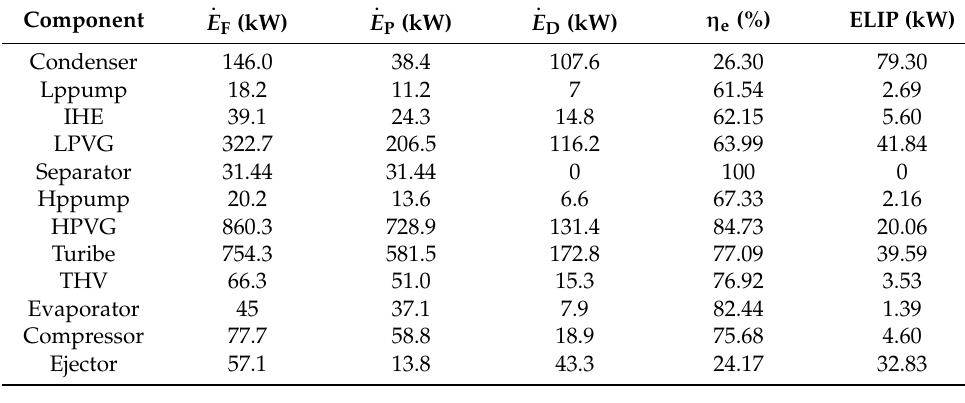
Table 11. Exergy analysis results of the system.